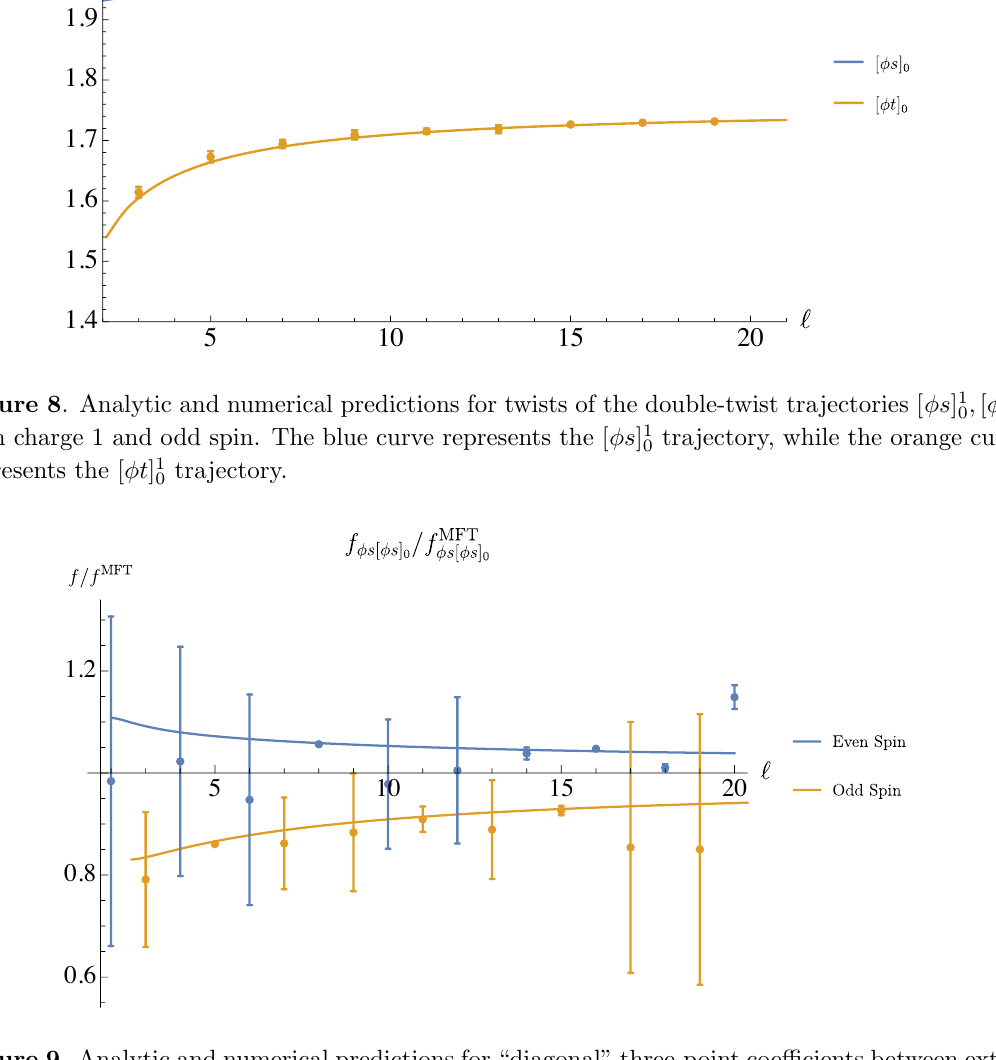
Figure 9 . Analytic and numerical predictions for \diagonal" three-point coe(cid:14)cients between exter- nal operators (cid:30) , s and operators on the double-twist trajectories [ (cid:30)s ] 1 and odd spin. The blue curve represents the even-spin trajectory while the orange curve represents the odd-spin trajectory. We divide each coe(cid:14)cient by the corresponding coe(cid:14)cient in Mean Field Theory